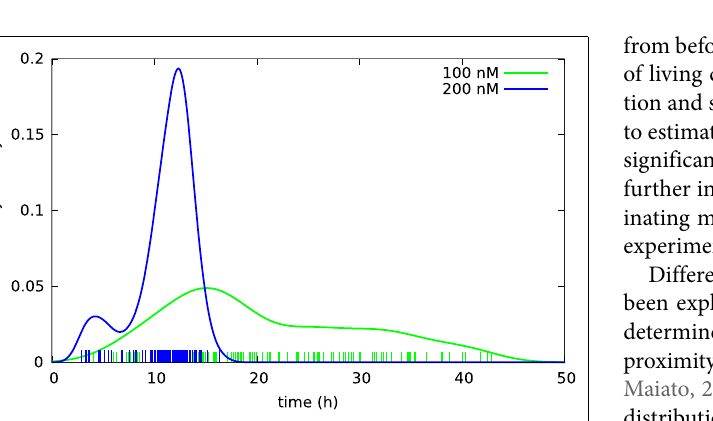
FIGURE 3 | Two sequences of four images respectively showing typical apoptotic- and necrotic-like death events among BC3H1 cells exposed to yessotoxin . The necrotic-like cell death process is much slower than the apoptotic-like cell death.